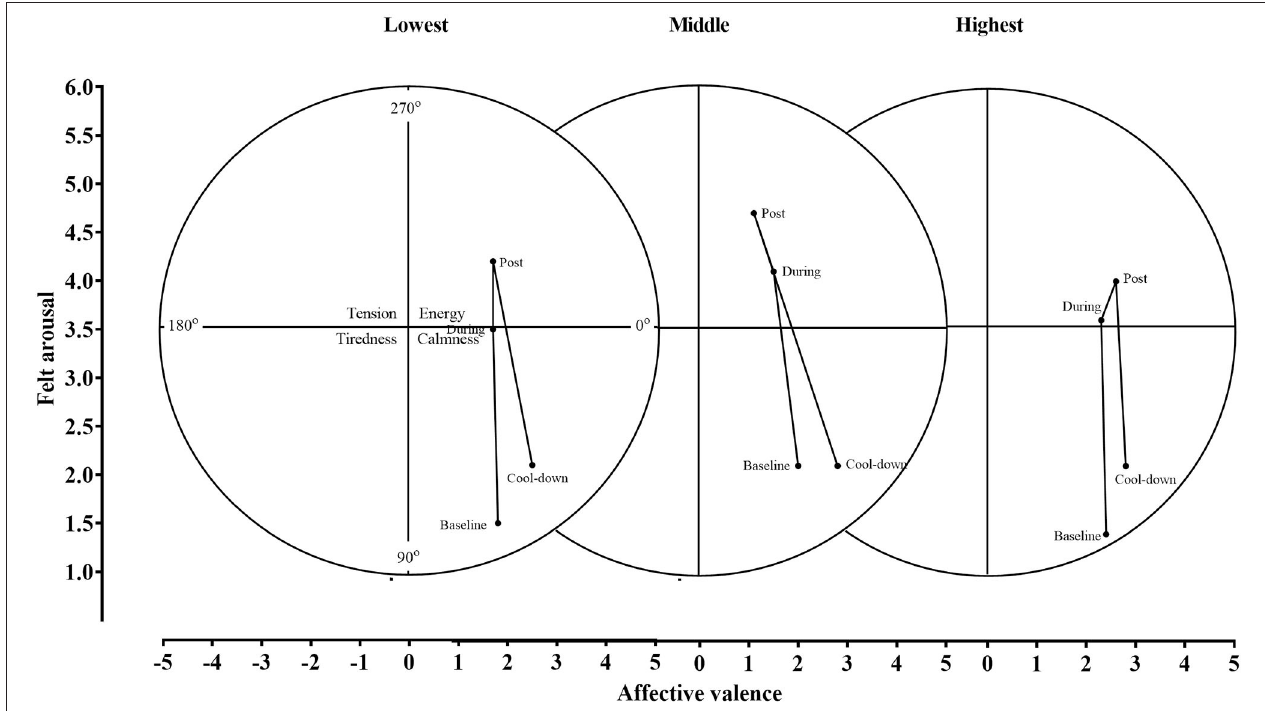
FIGURE 5 | The circumplex model applied to all